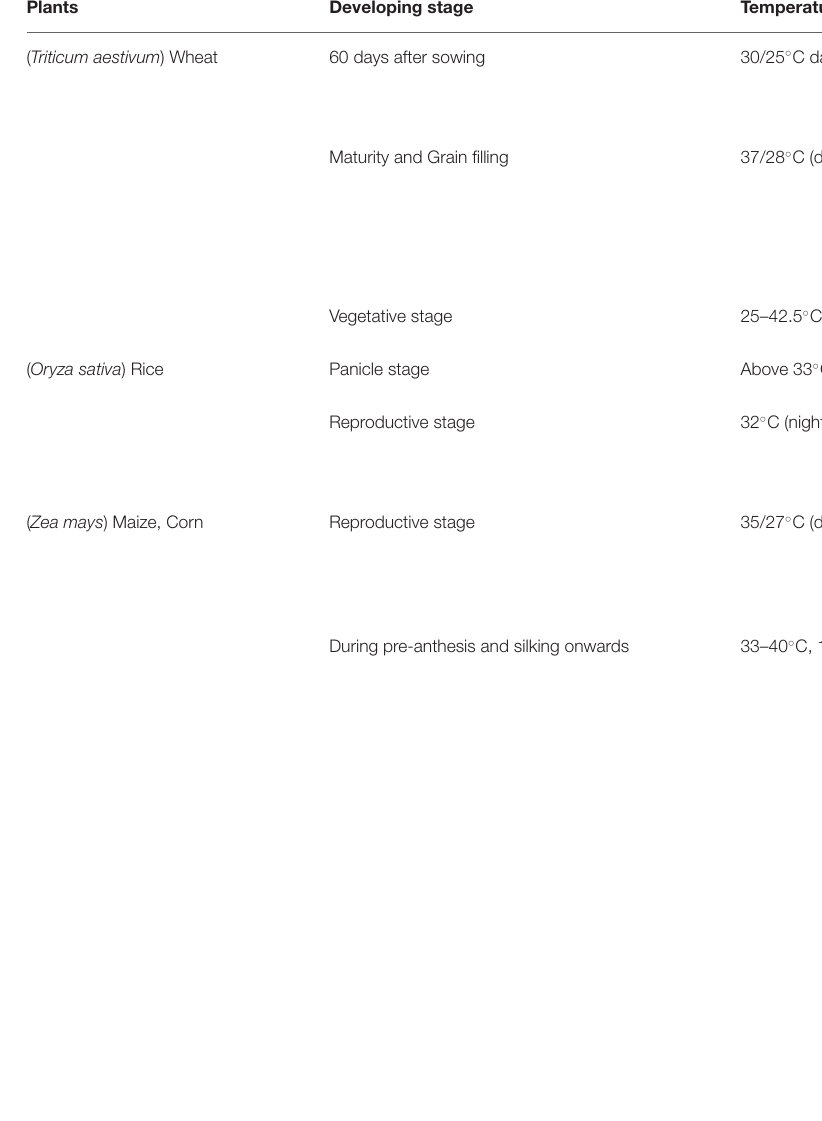
TABLE 2 | Effect of heat stress on different stages of plant growth in major cereals.